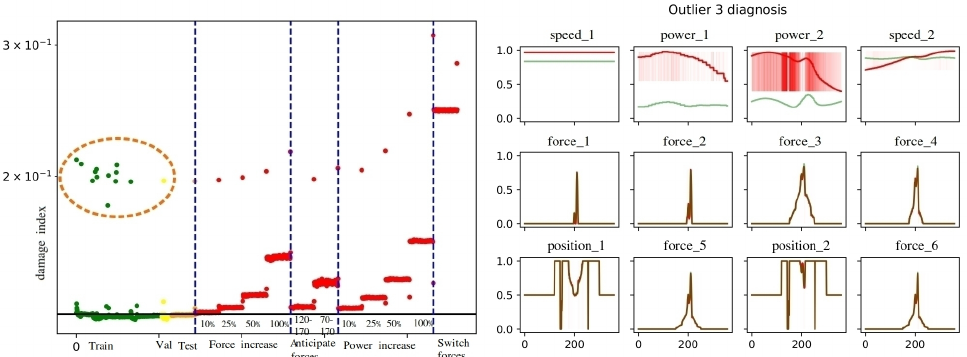
Figure 8. The right side contains diagnosis of outliers in training data using XAI. The left side contains predictions of 2D-CNN-AE damage index on train, validation, test and synthetic failure data, and training outliers are outlined in a dashed circle. Horizontal black line represents the anomaly detection threshold and dashed blue line splits data by each failure type, which are labeled based on their